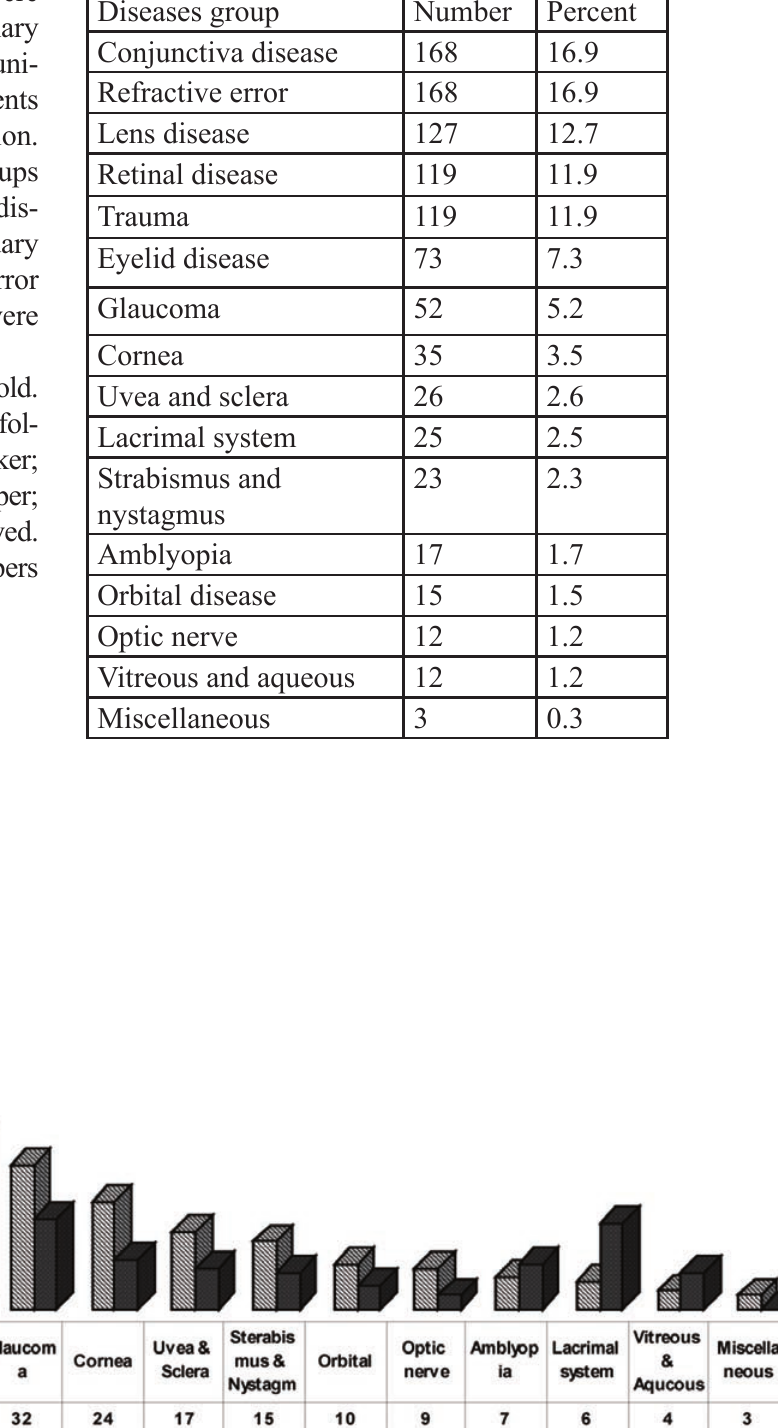
Table 1. The ocular disease frequency based on main group